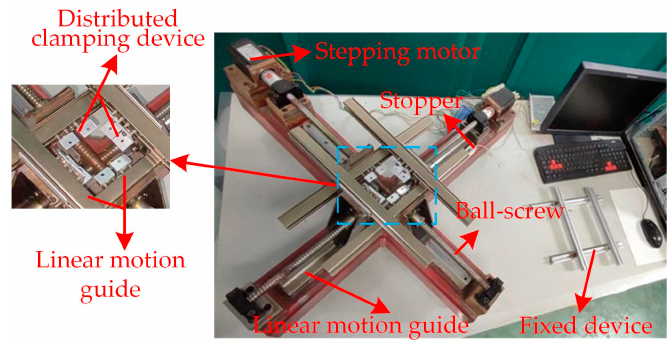
Figure 8. Experimental platform of the equibiaxial pre-stretching.